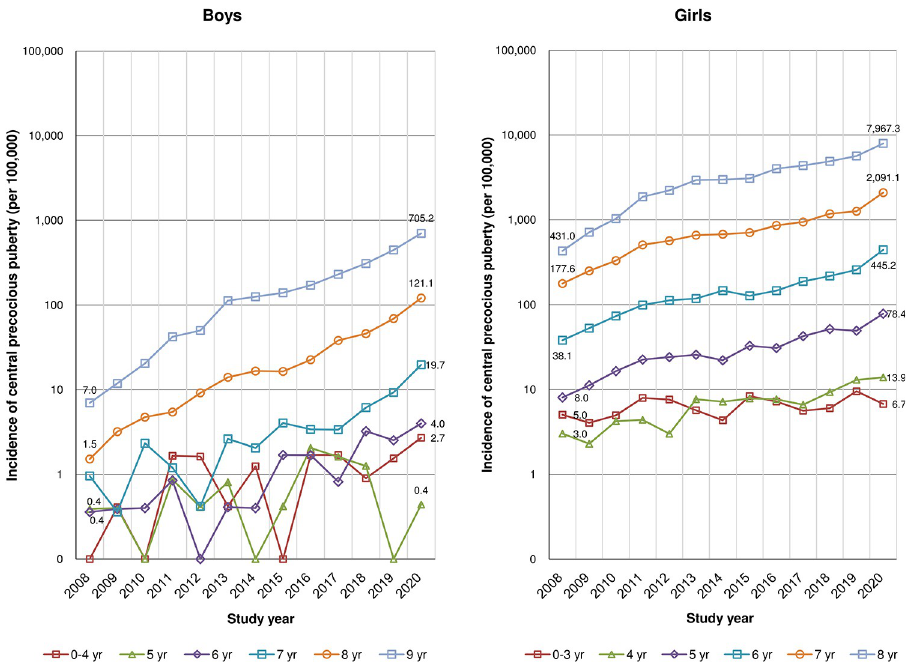
Fig 2. The annual incidence of central precocious puberty according to sex and age at diagnosis.